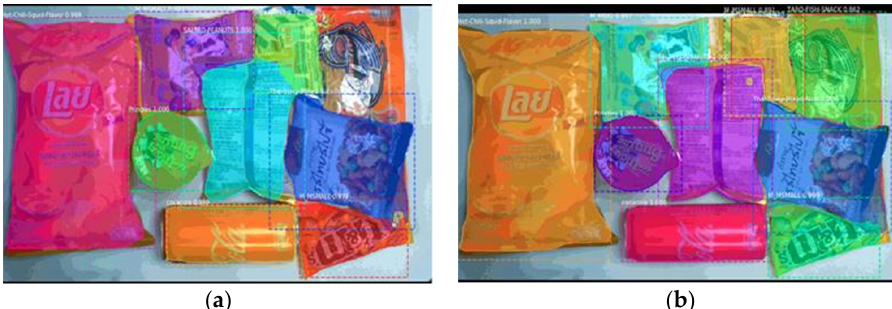
Figure 4. The utilization of DA algorithms: ( a ) results without the Das and ( b ) with the DAs. A Daubechies wavelet [15] is used instead of a Haar ‐ based wavelet for DWT. This